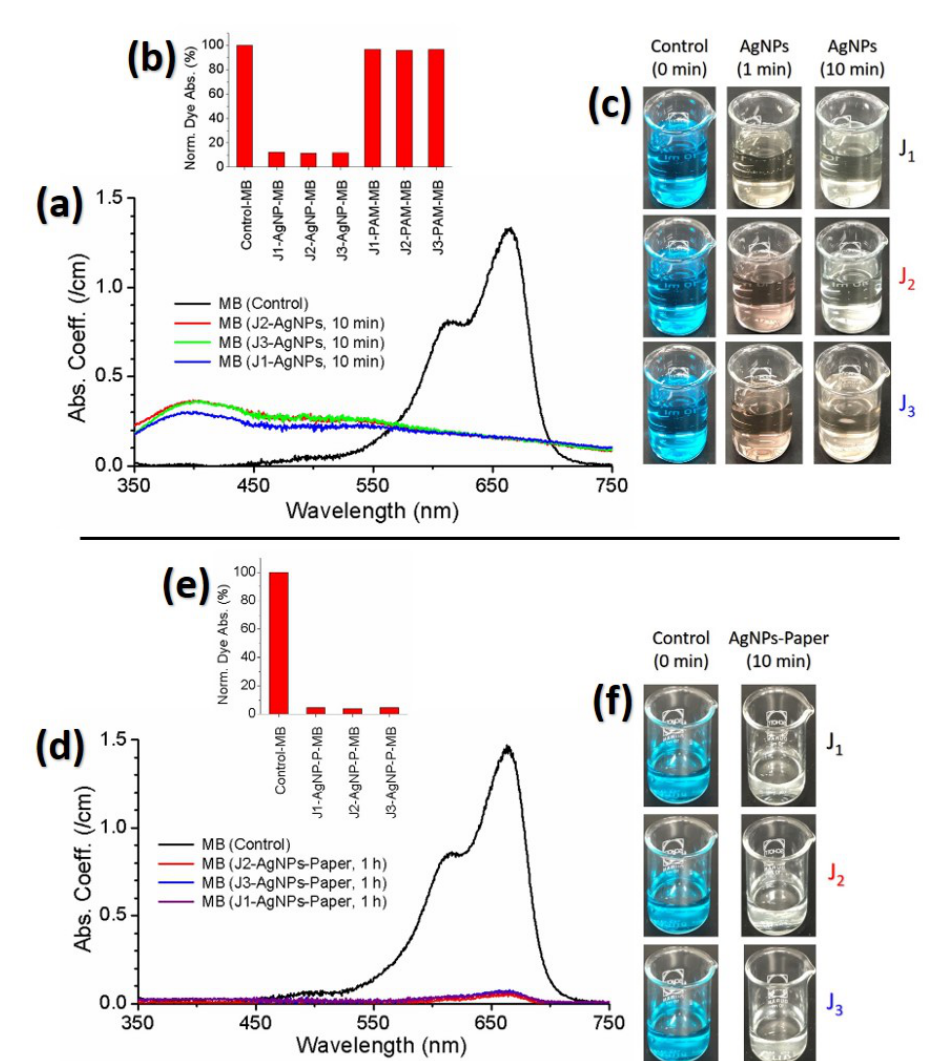
Figure 10. ( a ) Absorption spectra of Ag@Cit NP -treated MB solutions. ( b ) Dye degradation effects of